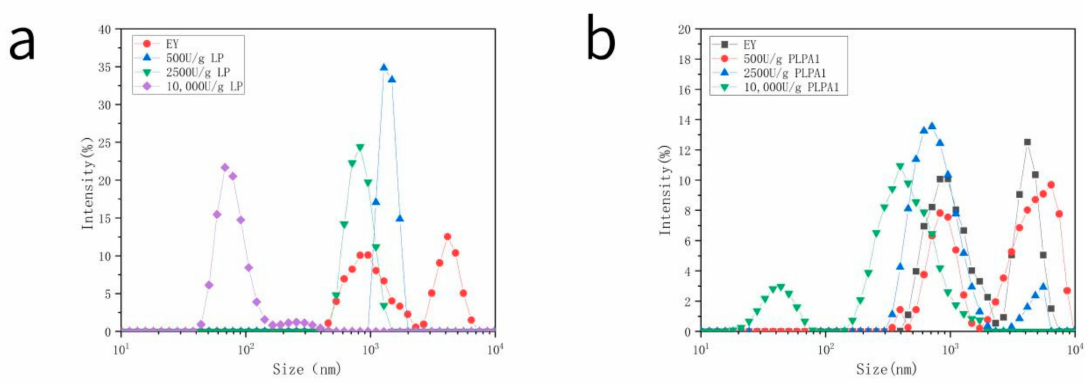
Figure 2. Particle size distribution of EY samples. Samples hydrolyzed by LP ( a ) and PLPA1. ( b ) under different enzymatic hydrolysis concentrations (500 U/g, 2500 U/g, 10,000